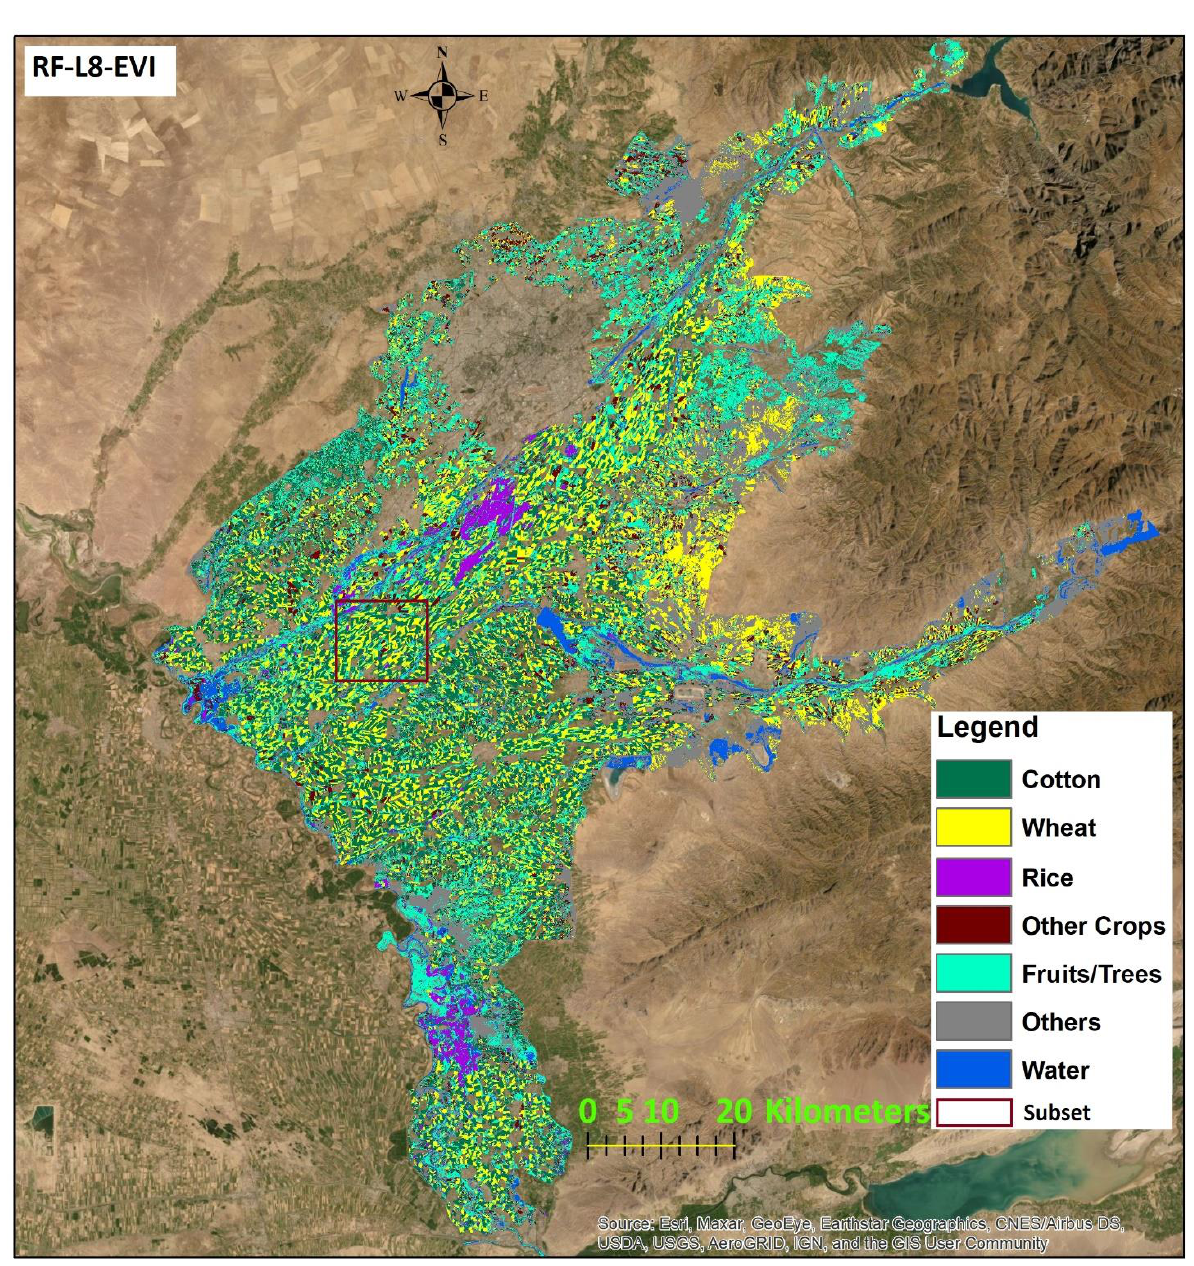
Figure 13. Classification result of L8-RF-EVI (highest OA 90% for RF).